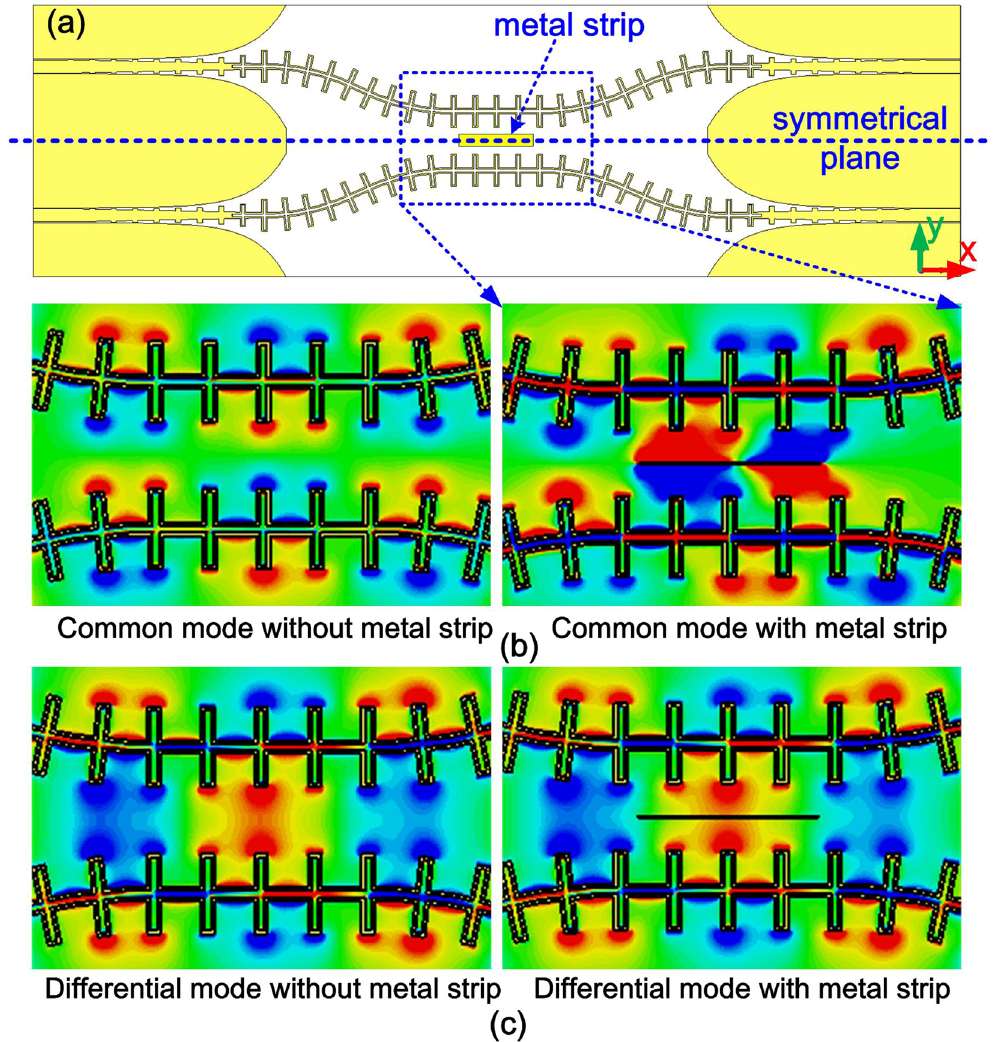
Figure 4. ( a ) Schematic of the differential plasmonic transmission lines. Comparisons of distribution of electric field E y at frequency of 3.5 GHz for common mode (b) and (c) for differential mode. The left figures of (b) and (c) are results without metal strips and right ones with metal